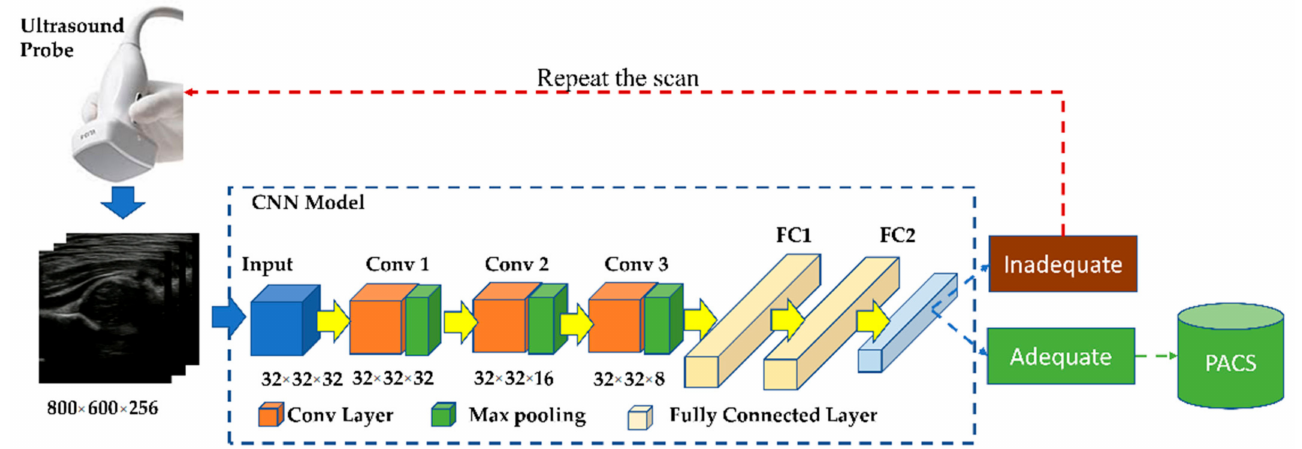
Figure 2. Overview of the proposed technique showing the CNN model consisting of 3 convolutional layers and 2 Fully Connected (FC) layers. Each convolutional layer consists of a convolution layer, ReLU activation and softmax (applied only in the slice